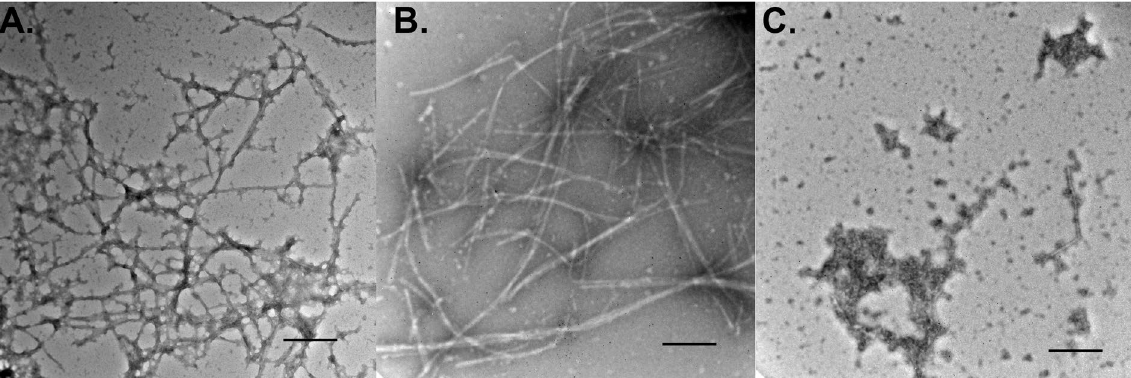
Figure 3. TEM analysis of 30D 0.5% PFF seeded α -syn aggregates. ( A ) Day 0, ( B ) Day 15, ( C ) Day 15 in the presence of D-520; Scale bar = 100 nm.